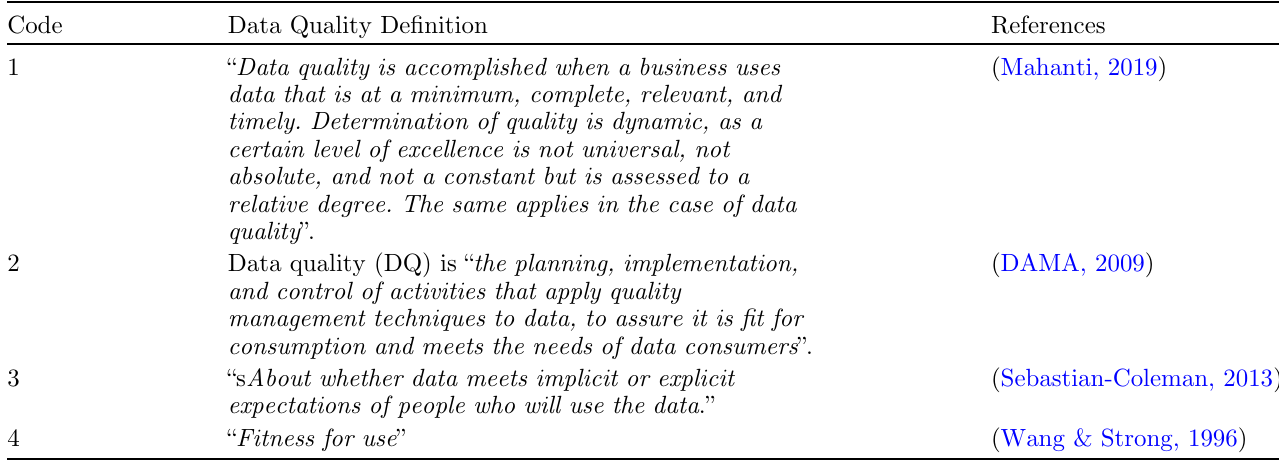
Table 1. A chronicle order for data quality de fi nitions. Code Data Quality De fi